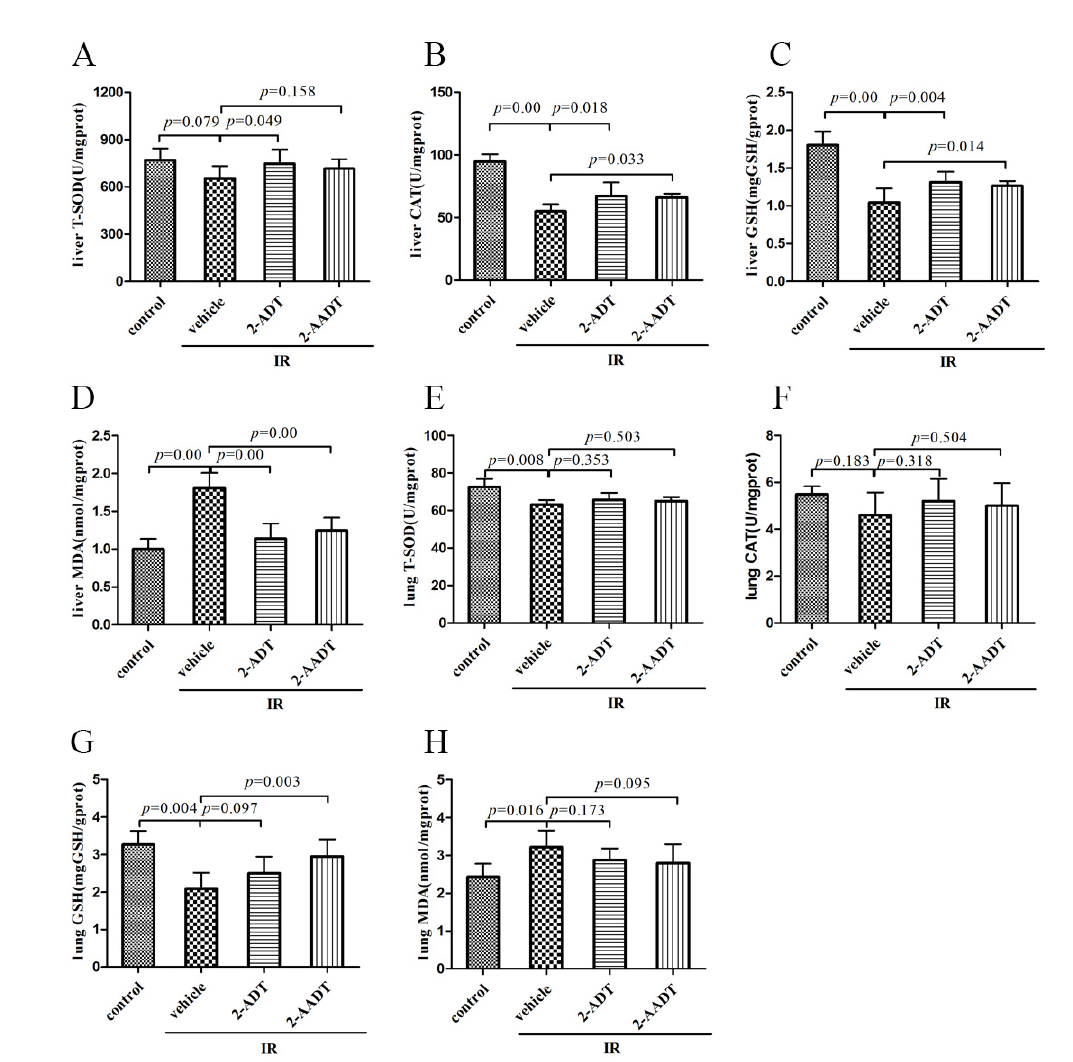
Figure 3. Effects of pretreatment with 2-ADT and 2-AADT on alterations of antioxidant enzymes activities in tissues after irradiation. 2-ADT and 2-AADT were administered i.p. 30 min before irradiation. ( A ) T-SOD; ( B ) CAT; ( C ) GSH and ( D ) MDA from liver 7 days after 6.0 Gy irradiation; ( E ) T-SOD; ( F ) CAT; ( G ) GSH and ( H ) MDA from lung 7 days after 6.0 Gy irradiation. The data are presented as the mean ± SD ( n = 8 each). One-way ANOVA was used for statistical comparisons between groups. The p value shows the difference compared with the IR + vehicle